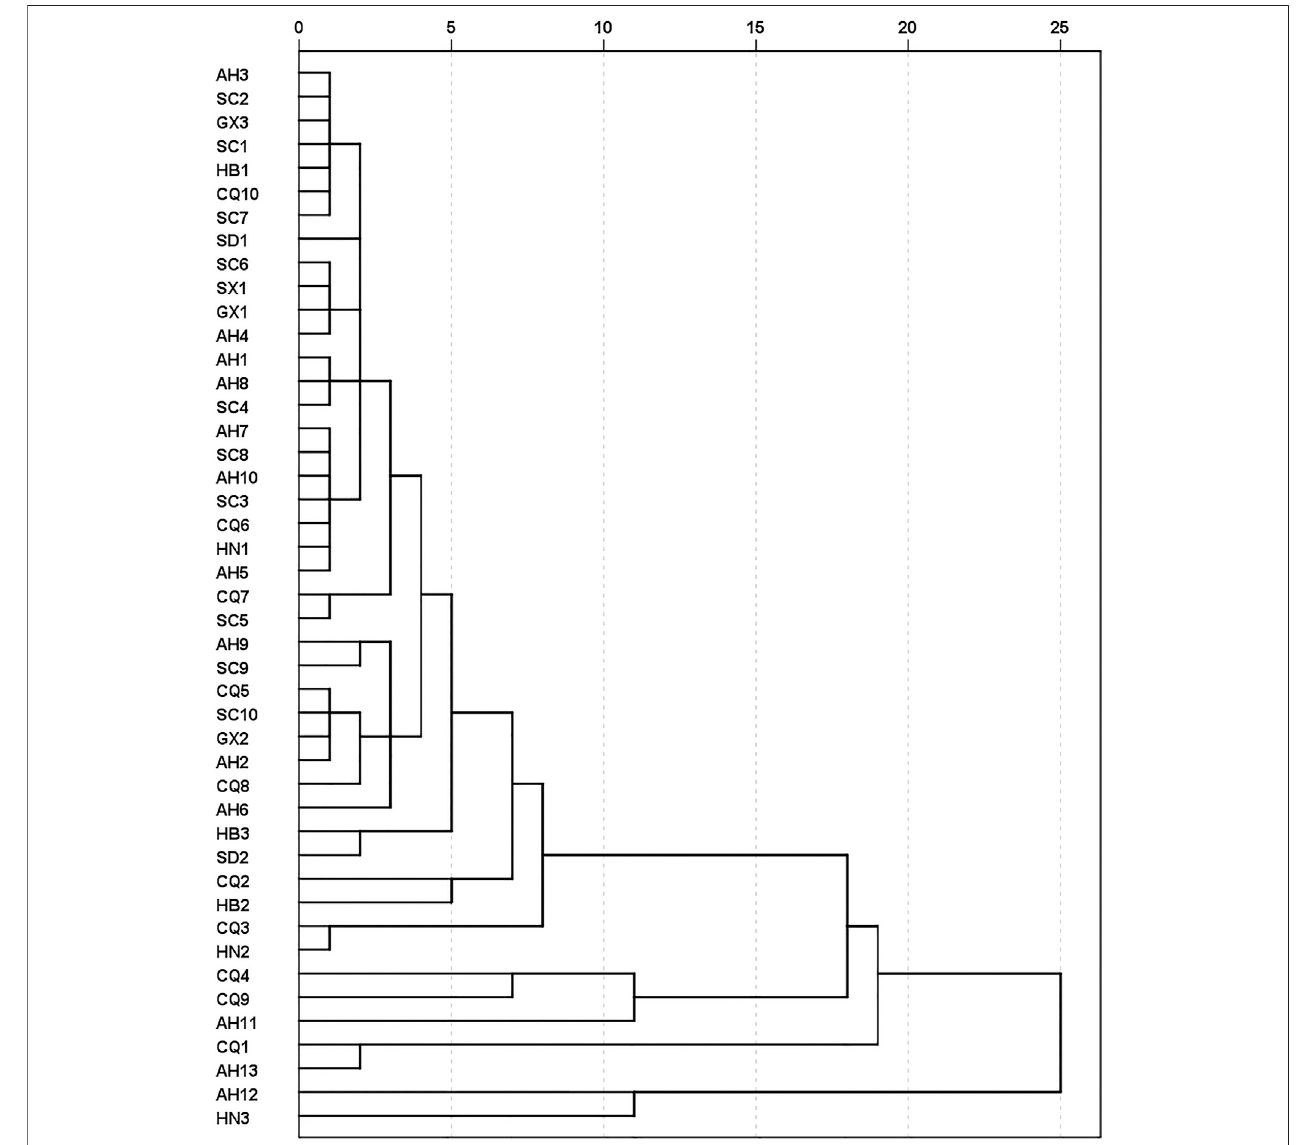
FIGURE2| HCA dendrogram ofthe45batchesofMCsamplesbased onthecombined dataofcontentsofdetected sixcomponents and anti-oxidative activities.